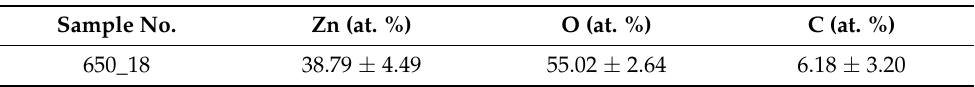
Table 2. Denotations and detailed specification of sample preparation. The values relate to atomic percentage.